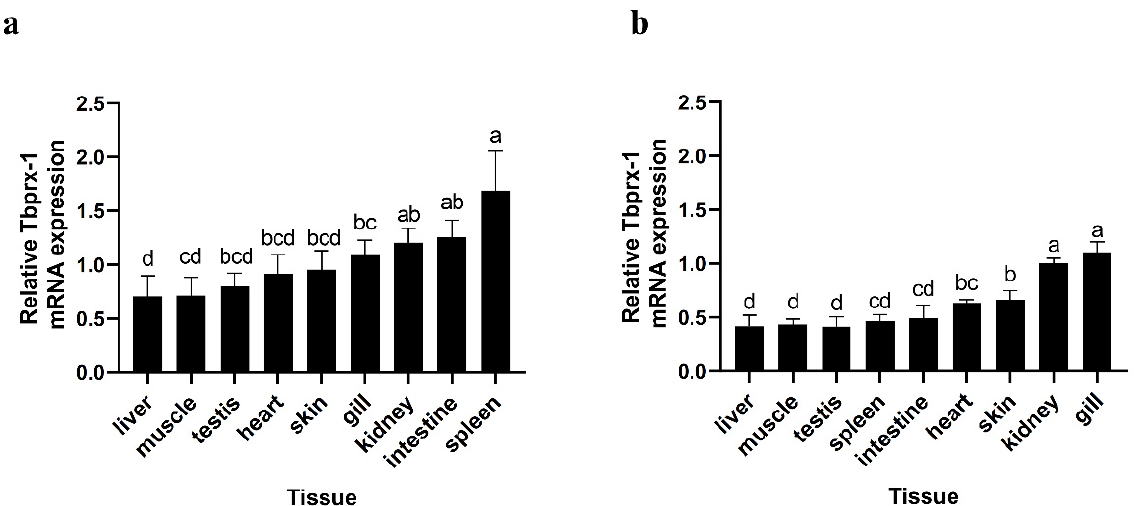
Figure 1. Expression of peroxiredoxin-1 in various tissues and organs for ( a ) immature and ( b ) mature T. bimaculatus . The housekeeping gene was 18S . Bars show the standard errors of mean values. The results were analyzed using an independent-samples t -test. Different letters (a,b,c,d) indicate significant differences in the same group ( p < 0.05); the same letter indicates no significant difference ( p > 0.05).